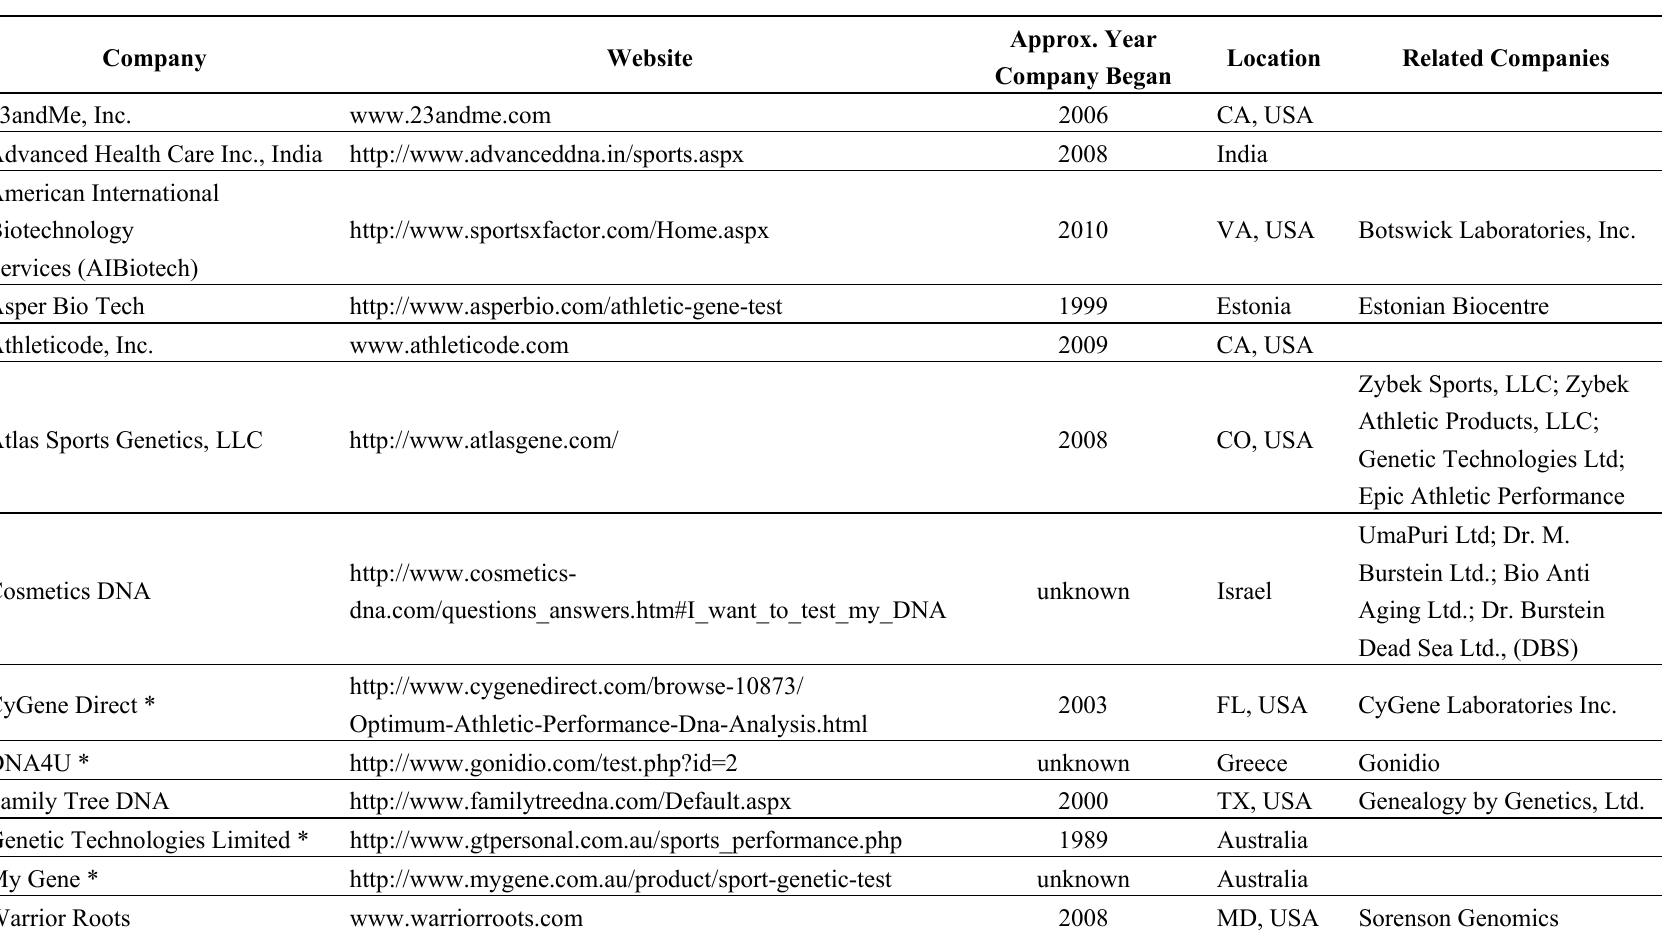
Table 1. Companies providing sports-related DNA tests or